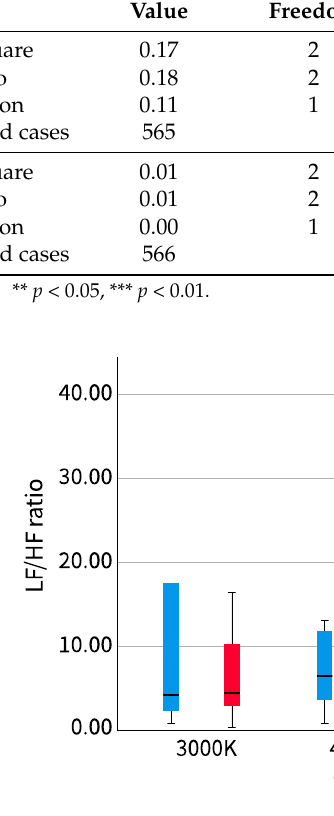
Figure 5. LF/HF ratio boxplot (sex).